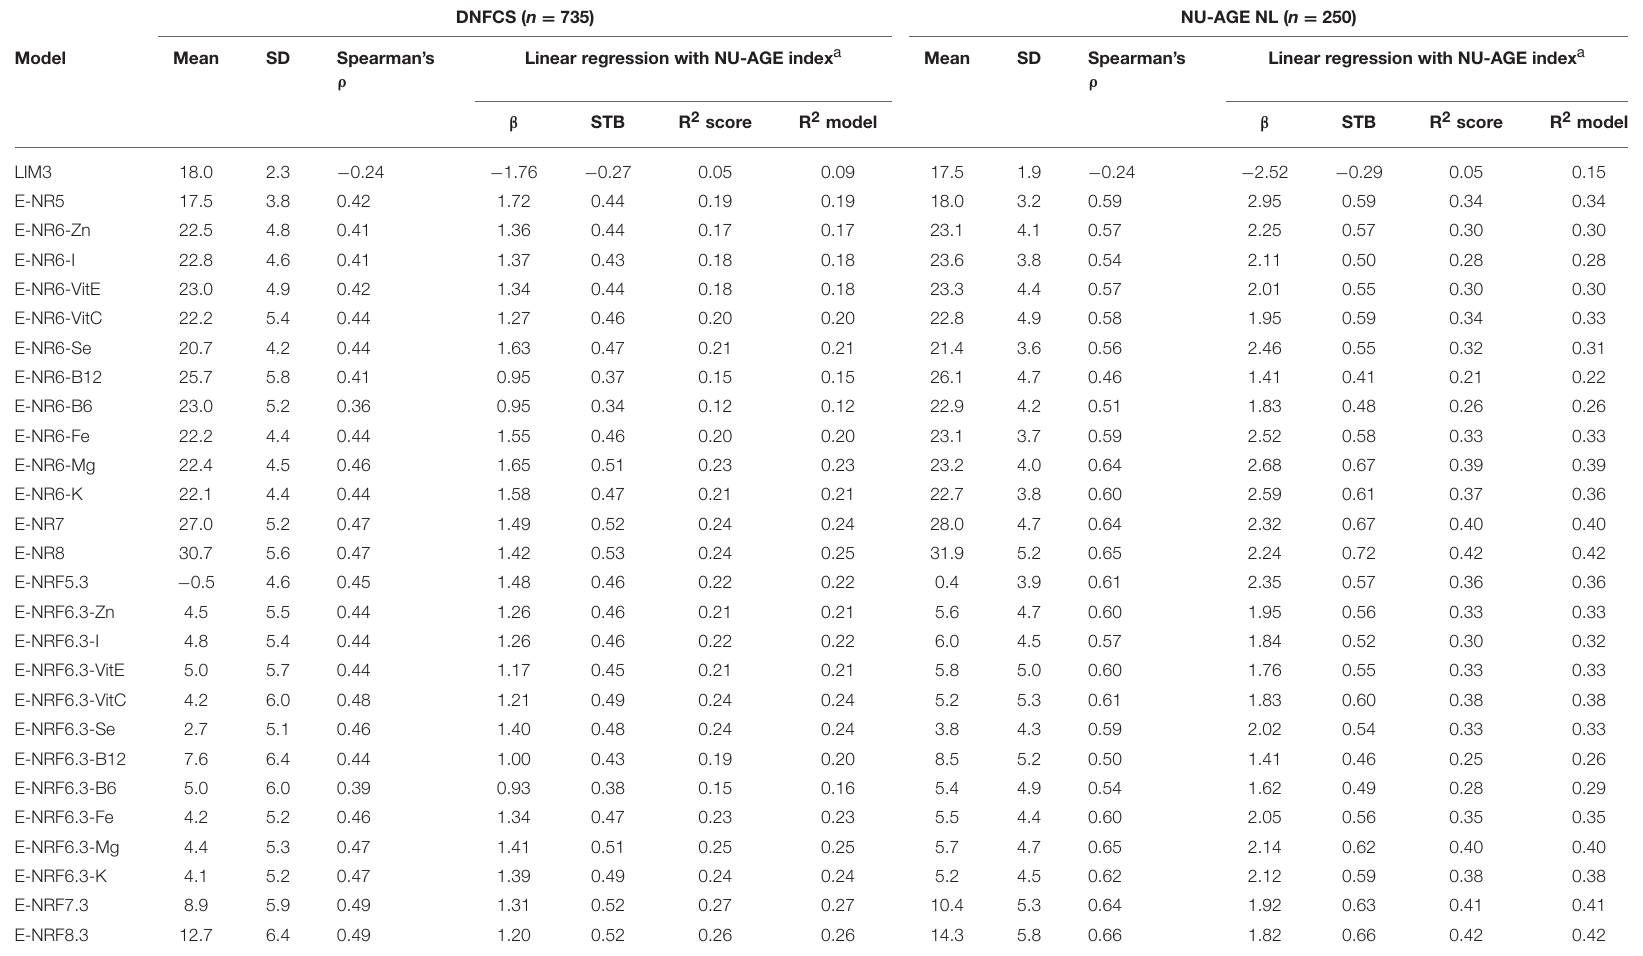
TABLE 6 | Correlation coefficients and linear regression analyses of the E-NRF scores on the NU-AGE index within DNFCS ( n = 735) and NU-AGE study ( n = 250). DNFCS ( n = 735) NU-AGE NL ( n =